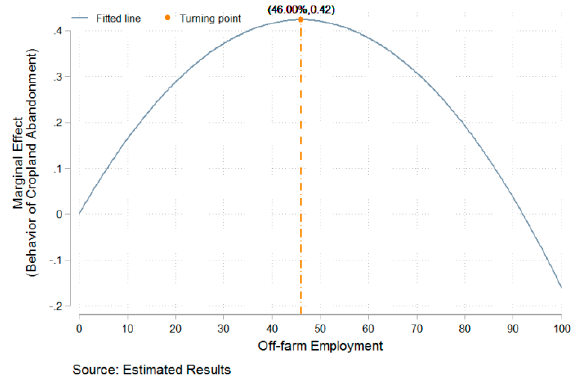
Figure 3. The function of marginal effect of off-farm employment on behavior. Int. J. Environ. Res. Public Health 2018 , 15 , x